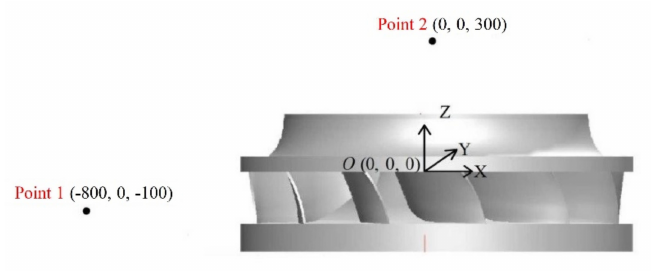
Figure 10. The location of noise measurement Points 1 and